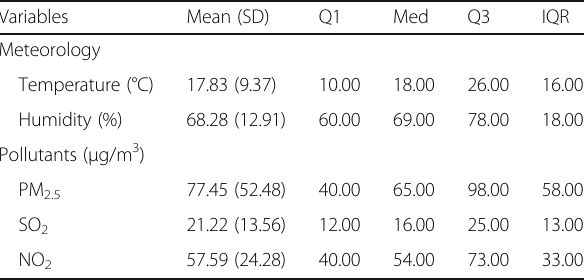
Table 2 Air pollutant concentrations and weather conditions in Shanghai, China, from 1 June 2012 to 31 May 2014